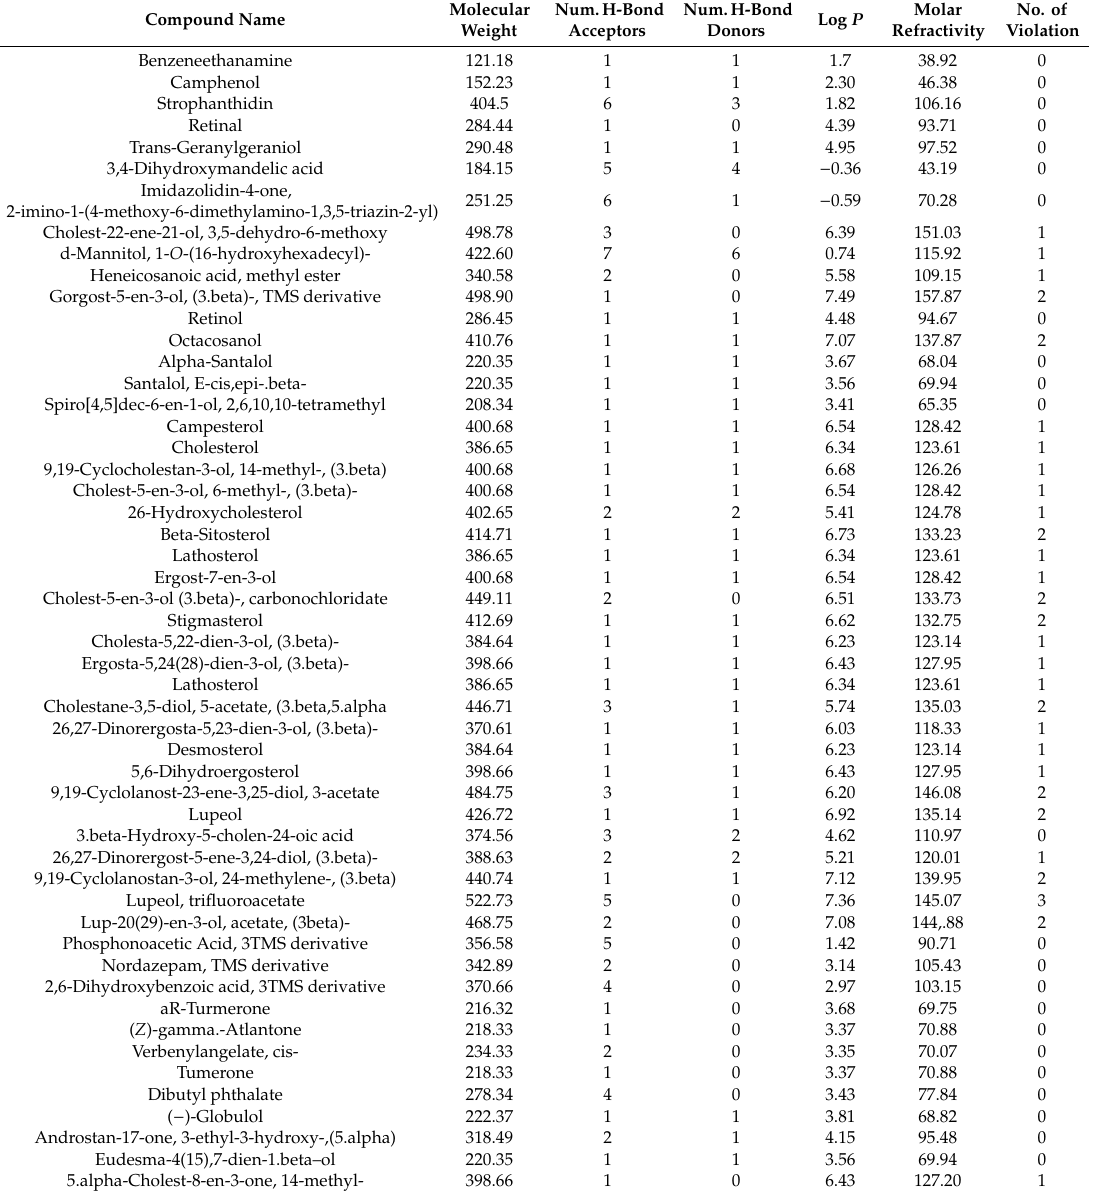
Table 2. ADME properties of selected compounds methanol extract of T. crispa by